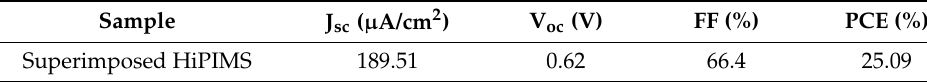
Figure 6. Stability data of unsealed devices from superimposed HiPIMS under the argon glove box.